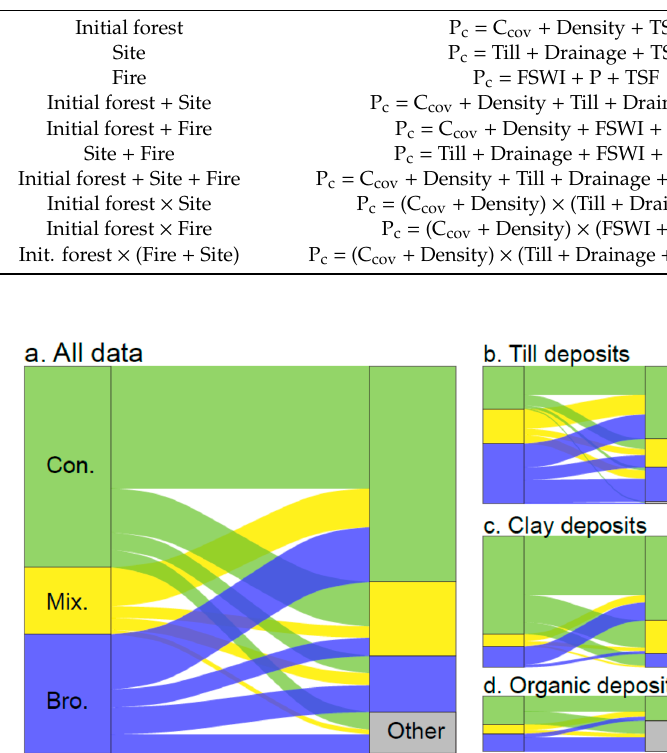
Figure 2. Transition diagrams in forest cover classes from 1930s (left) to 1990s (right) for all data ( a ), by deposits classes ( b – d ) and by fire severity weather index classes (FSWI; e , f ). Forest classes are coniferous (green), mixed (yellow) and broadleaved (blue) and other non-forested (gray; exclusively wet barrens and alder swamps). The size of individual diagrams in ( b – d ) and ( e , f ) are proportional to the representation of surface deposits and fire severity classes in the sampled sites.